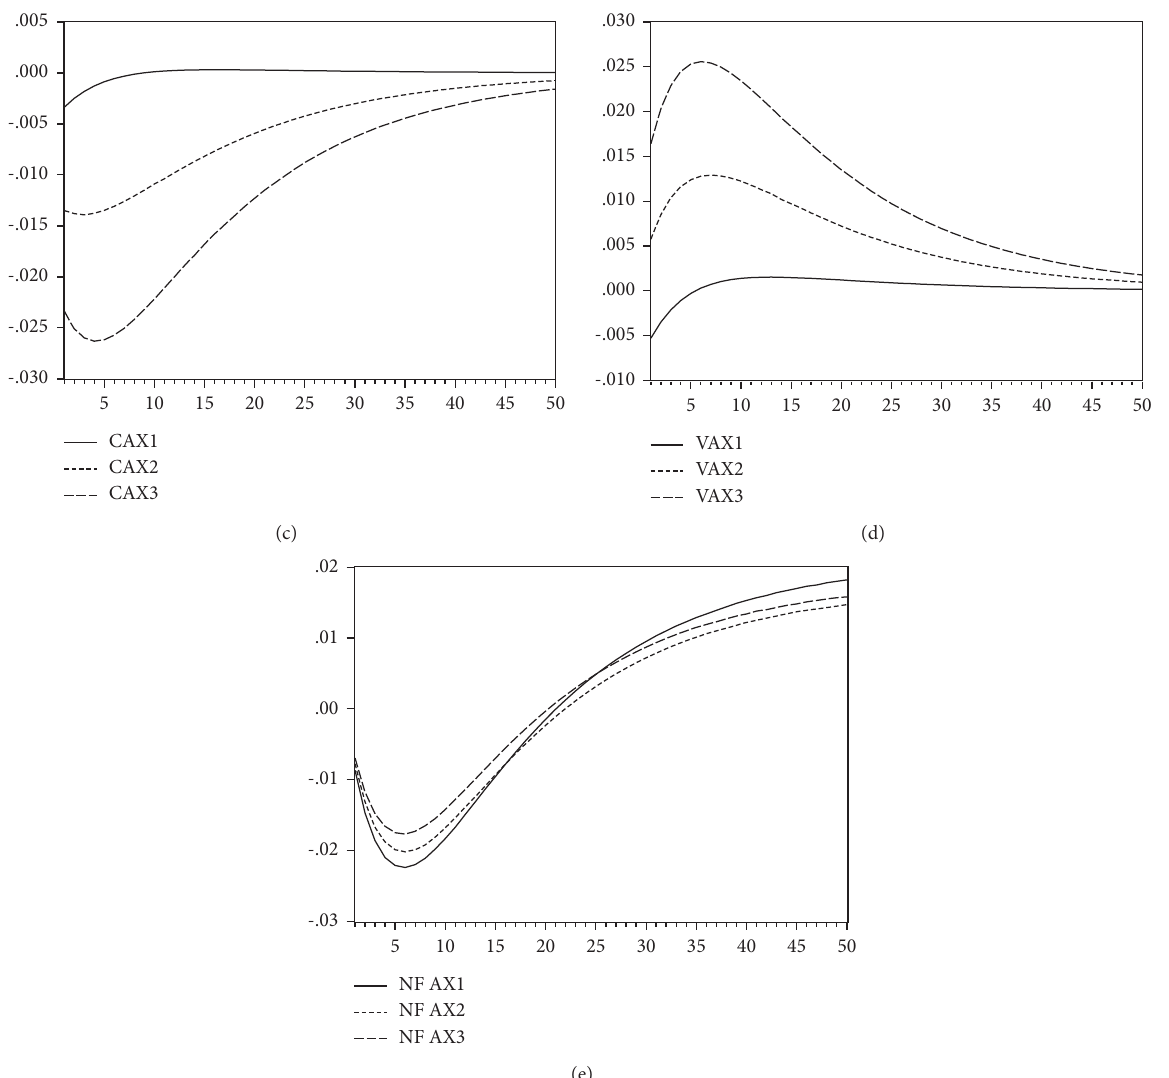
Figure 2: Investment efficiency improvement shock (1%), the dynamic response of variables under different degrees of investment openness. Note: The solid line, the short dotted line, and the long dotted line represent the τ value at 0.01, 0.10, and 0.20, respectively. SFX represents the impulse response route of SF after being impacted by investment efficiency improvement (X), then SFX1, SFX2, and SFX3 represent the dynamic trend of the share of outward investment impacted by investment efficiency improvement when the τ value is at 0.01, 0.10, and 0.20, respectively. Q , CA, VA, and NFA express the same meaning as